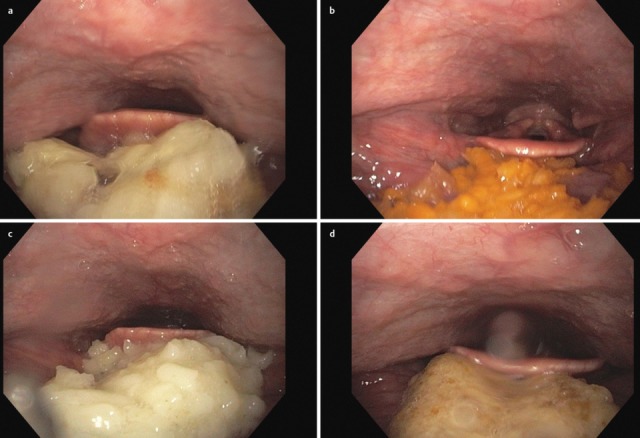
Position 1 – oF = level of the palatal arch, the bolus is collected over the back of the tongue in the valleculae: a – preparation of swallowing apple; b – preparation of swallowing carrots; c – preparation of swallowing spaghetti; d – preparation of a semi-solid bolus.